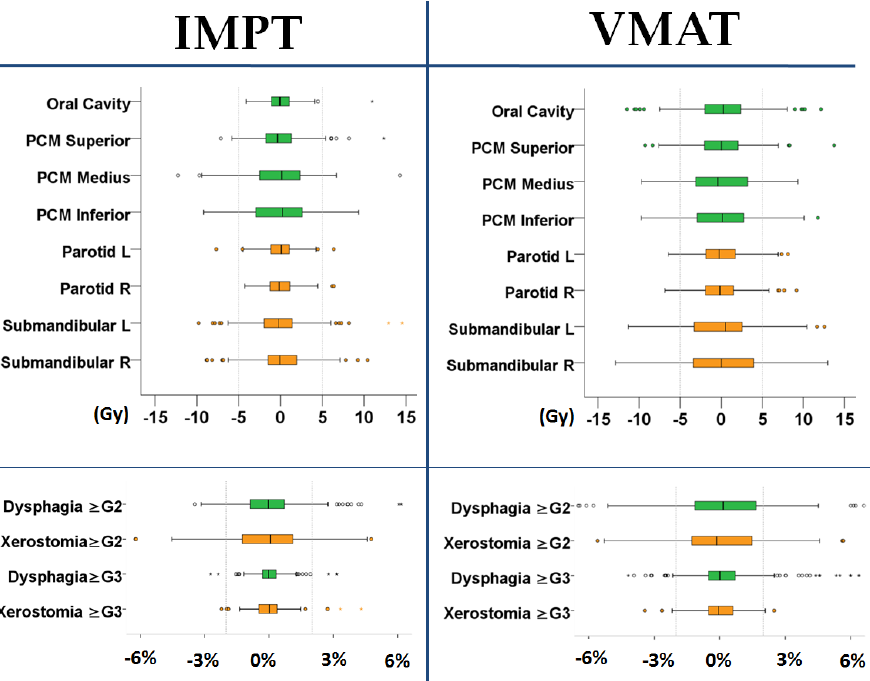
Figure 5. The boxplots of the residuals, i.e., the difference between predicted and actual OAR D mean ( upper ) and NTCP values ( lower ) for IMPT and VMAT. Dysphagia- and xerostomia-related OARs and NTCPs are shown in green and orange, respectively. Dots in the figure represent outliers, i.e., values more than 1.5 interquartile range (IQR) but less than 3 IQR from the end of the box).